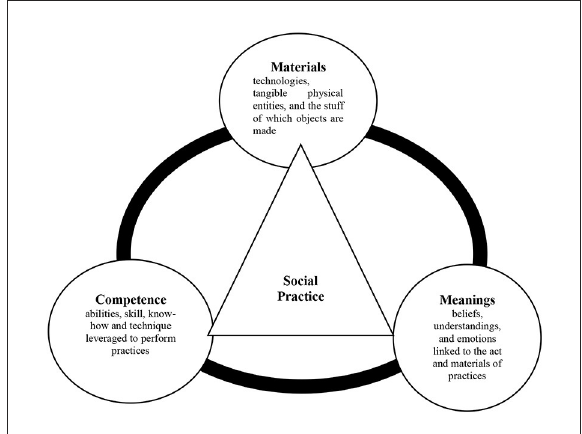
FIGURE1 Elements of social practices. Source: Adapted from Shove et al.